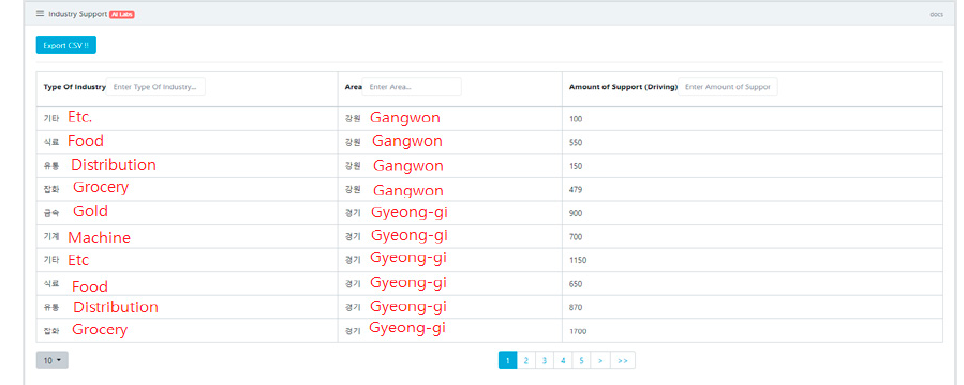
Figure 25. Data statistics of the supported industry.